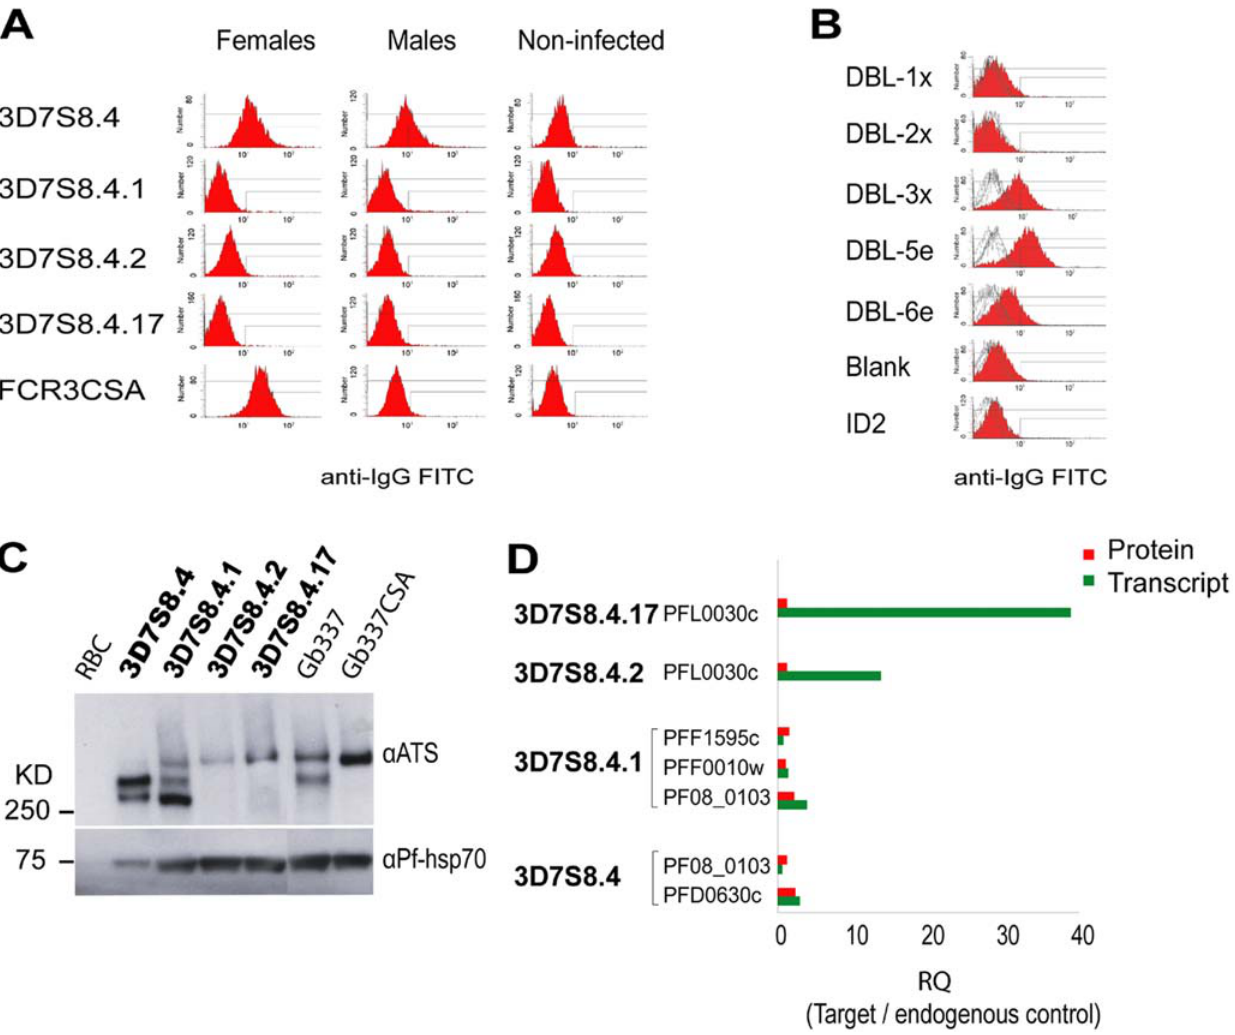
Figure 5. Detection of PfEMP1 in different P.falciparum clones by flow cytometry- and immunoblotting. The IEs were labeled (A) with IgG from plasma pools of P. falciparum exposed males (Males), females (Females) or non-infected Danes, and (B) IEs used in (A) were labeled with IgG from rabbit-sera raised against different domains of VAR2CSA (DBL-1x; DBL-2x, DBL-3x, DBL-5e, DBL-6e) or with a serum raised to an irrelevant control antigen (ID2), positive control (FCR3CSA) is shown in red. (C) The blot illustrates the PfEMP1 expression in whole cell-lysates of late trophozoite infected RBCs of the 3D7S8.4 early and late generation clones. Parasites with bolded lettering are described in greater detail in D. The blot was incubated with a PfEMP1 antibody raised against the conserved part of the acidic terminal segment (ATS). Anti-PfHsp-70 reactivity was used as loading control. Uninfected RBCs were included as negative control. Gb337 and Gb337CSA are included as positive controls of VAR2CSA expressing parasites. Whilst Gb337 is heterogeneous in its PfEMP1 expression, upon repeated panning on CSA, only the higher molecular weight protein is expressed. D) The graph illustrates the inter-relationship of the transcript versus protein levels of the dominant var -gene(s) in the 3D7S8.4 early and late generation